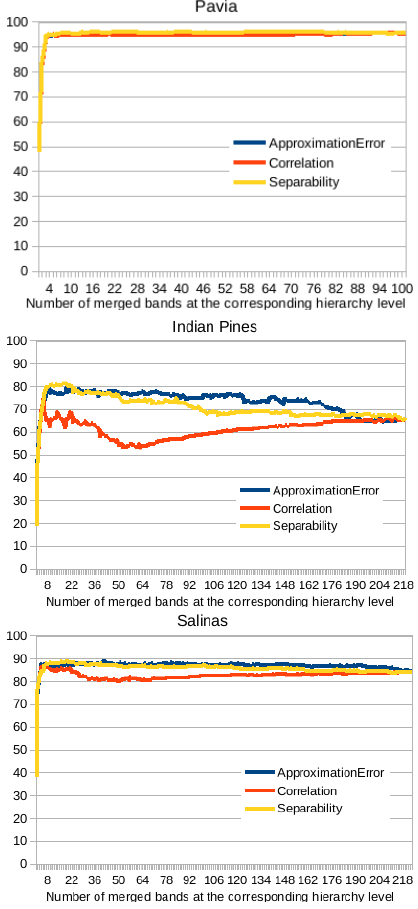
Figure 4: Kappa (in %) reached by a rbf SVM for the different band configurations of the hierarchy (x-axis = number of merged bands in the spectral configuration corresponding to the hierarchy level), for Pavia (top), Indian Pines (middle) and Salinas (bottom) data